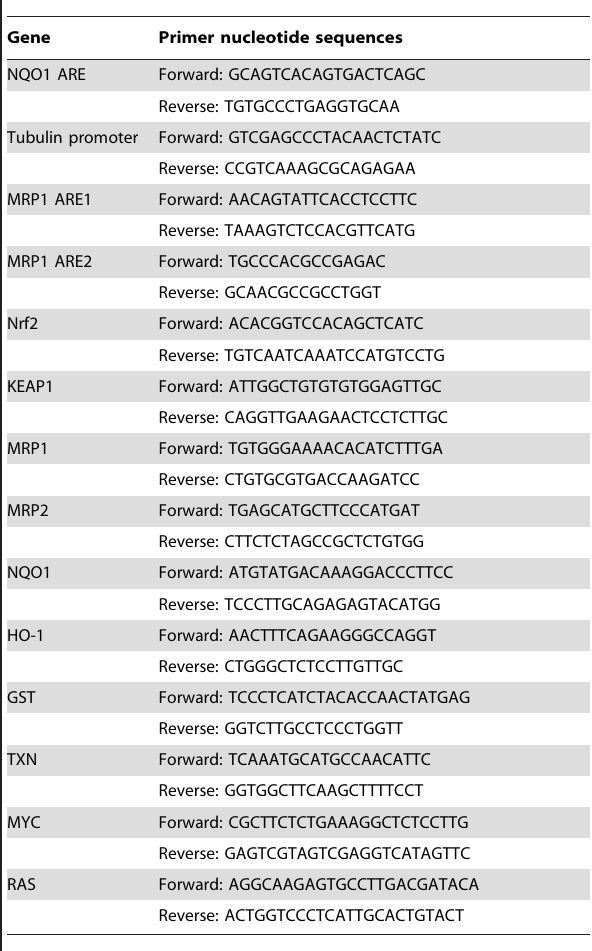
Table 2. Primers used in qRT-PCR